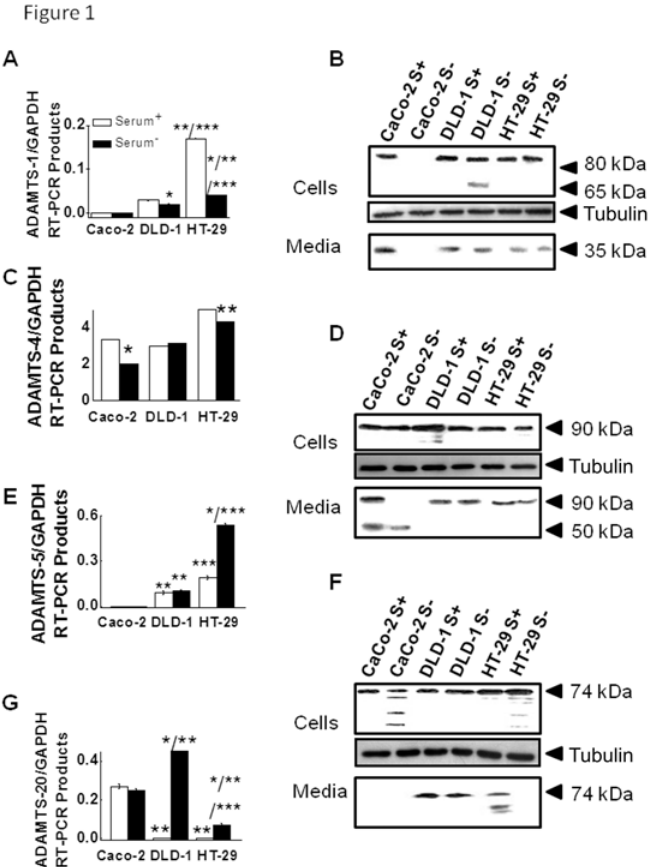
Fig 1. Expression of ADAMTSs in cancer cell lines. Semi-quantitative RT-PCR analysis of (A) ADAMTS- 1, (C) ADAMTS-4, (E) ADAMTS-5 and (G) ADAMTS-20 in cultured cells (white/black column; presence/ absence of serum). Values are the mean GAPDH-normalized ± S.D. (B) ADAMTS-1, (D) ADAMTS-4 and (F) ADAMTS-5 protein distribution in cell extracts and in media of cultured cells. (S +/- : presence/ absence of serum) * P (cid:1) 0.05; statistically significant differences compared to cells cultured in the presence of serum. ** P (cid:1) 0.05; statistically significant differences compared to Caco-2 cells, *** P (cid:1) 0.05; statistically significant differences compared to DLD-1 cells. For comparison, tubulin immunoidentification in cell extracts was included in B, D and